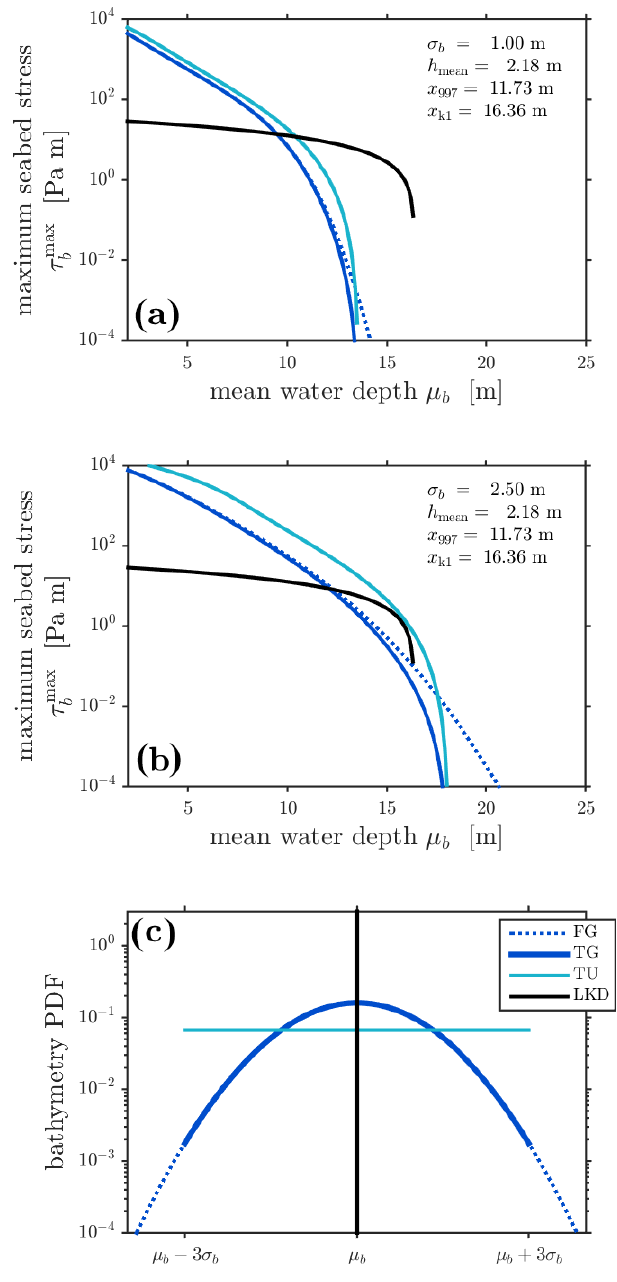
Figure 3. Maximum seabed stress τ max computed with Eq. (3) us- b ing the ice thickness distribution of Fig. 1a, fitted with a lognormal distribution with mean m = 2 . 18m and variance v = 3 . 03m 2 , trun- cated at x 997 = 11 . 73m, as a function of the mean water depth µ b with standard deviation σ b = 1 . 0m (a) and σ b = 2 . 5m (b) , on a log- arithmic scale. The friction coefficient is set to µ s = 0 . 7. The three bathymetry probability density functions (PDFs) are shown in (c) : a full Gaussian distribution (FG, dashed blue), a truncated Gaus- sian distribution (TG, blue) and a uniform distribution (TU, blue- green) both truncated at ± 3 σ b . The LKD method with k 1 = 7 . 5 and k 2 = 15Nm − 3 is represented in black, and, since it is independent of σ b , its bathymetry distribution is a Dirac delta function (e.g. the vertical line in c